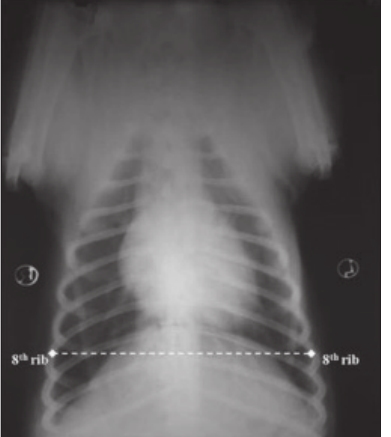
Figure-3: Thoracic width measured as the distance between medial borders of eighth rib at their most lateral curvatures in dorso-ventral